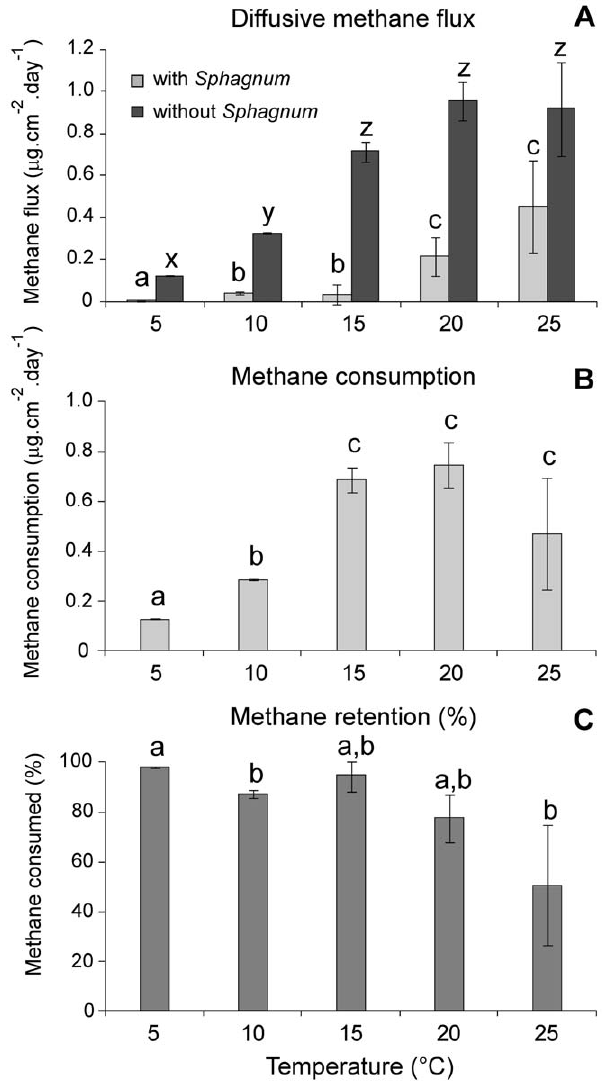
Figure 2. Methane cycling at different temperatures. A) Diffusive methane flux, with and without Sphagnum , B) methane consumption, the difference in methane flux before and after removal of Sphagnum , C) methane retention. Fluxes are measured on small peat cores after two months of incubation and values are expressed in m g.cm 2 2 .day 2 1 . Methane retention is expressed in % of the initial flux measured without Sphagnum . Values represent means of triplicate incubations 6 s.d. Letters indicate statistically significant groups of data ( P , 0.05). Diffusive methane flux data with and without Sphagnum were not compared to each other.